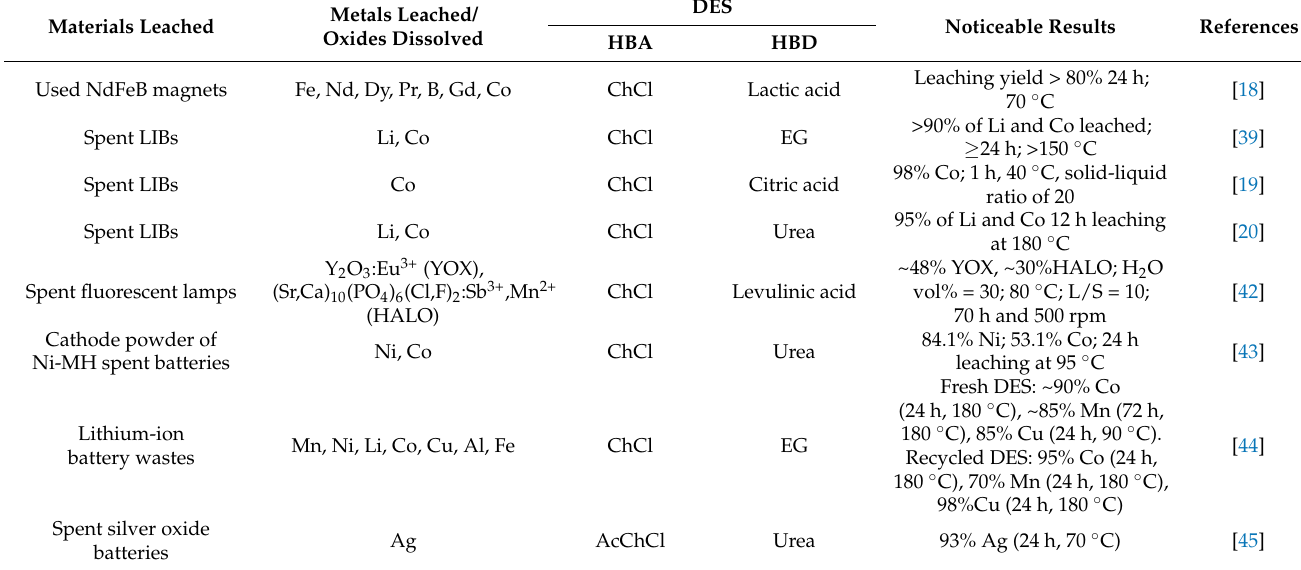
Table 1. Deep eutectic solvents (DESs) used for the leaching of metals from e-waste. Materials